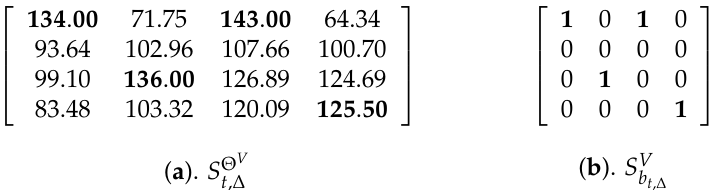
Figure 9. ( a ) Smoothed thresholded difference frame S Θ V maxima in S V are (1,1), (1,3), (3,2), and (4,4); the values at these positions in S V b t , ∆